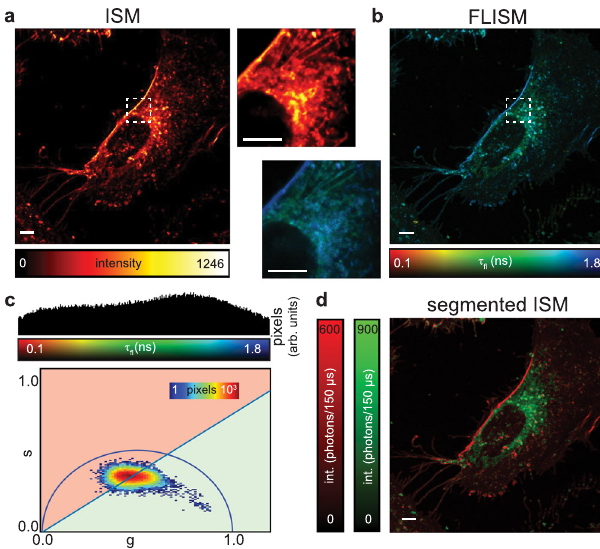
Fig. 4 | Fluorescence lifetime image-scanning microscopy in live cells. a Intensity-based ISM image and b lifetime-based FLISM image of live HeLa cells stained with the polarity-sensitive fl uorescent probe di-4-ANEPPDHQ. Side images depict the areas within the dashed white boxes. c Histogram distribution of the fl uorescence lifetime values (top): number of pixels versus lifetime values. Pixel intensity thresholded phasor plots (bottom): number of pixels versus the polar coordinate(10%thresholds). d Phasor-basedsegmentation,i.e,imagesobtainedby backprojection of points within the red (long lifetime, ordered membrane) and green(shortlifetime,disorderedmembrane)area.Scalebars5 μ m.Pixeldwelltime 150 μ s.Whilehereweshowonecell,thisexperimentwasindependentlyperformed two times on the same HeLa cell line. Setup: custom-built single-photon laser- scanning microscope equipped with a 5×5 SPAD array detector